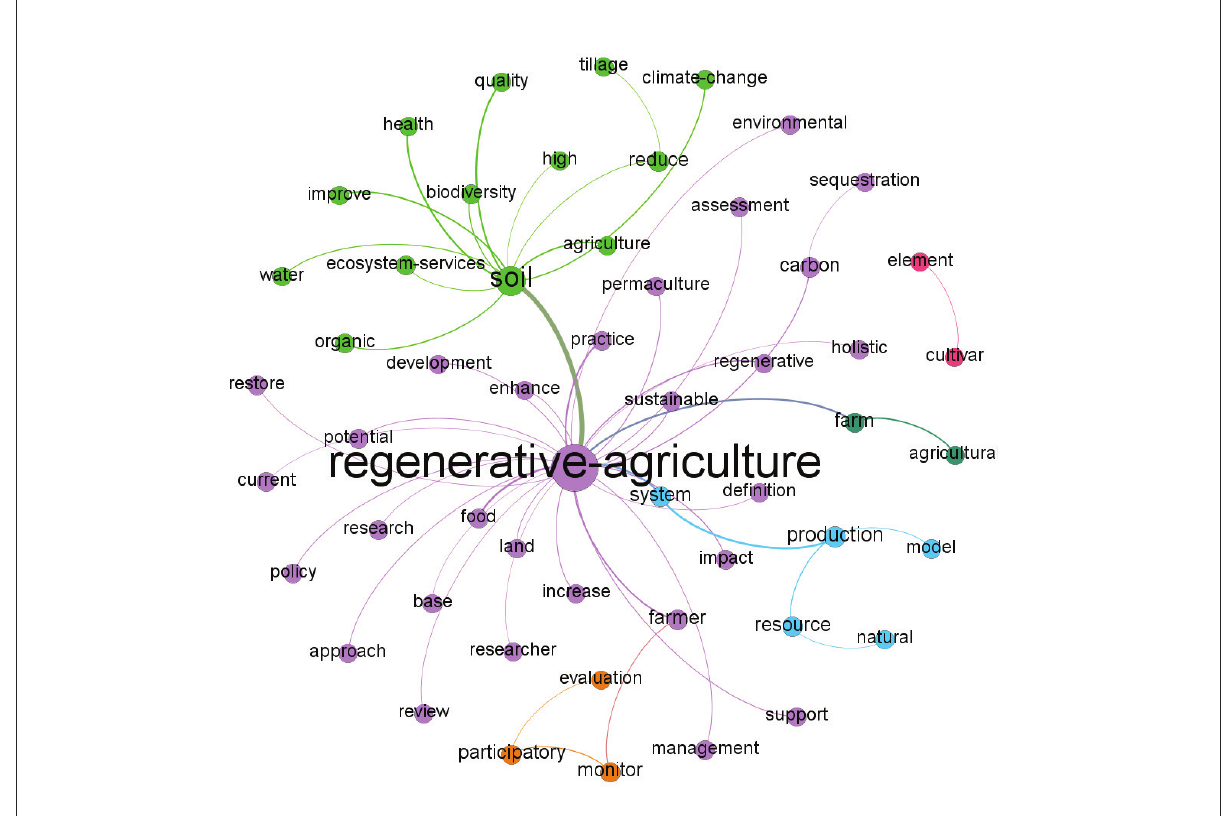
FIGURE3 Co-occurrence of terms from the text of the title, abstract and keywords of 29 articles including “regenerative agriculture” in the article title. The network was based on a minimum of 5 co-occurrences between two terms, size of bubbles and text is proportional to term’s grade (number of connections), and thickness of connections to the number of co-occurrence.